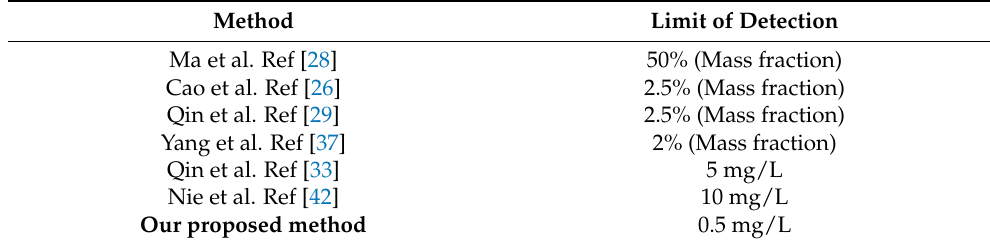
Table 1. The carbendazim limit of